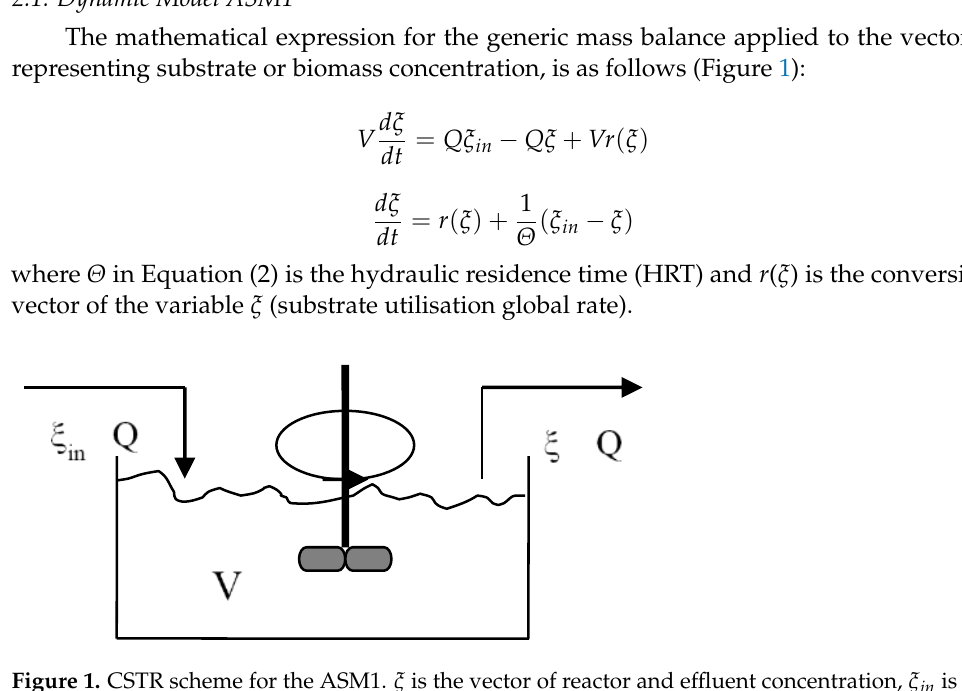
Figure 1. CSTR scheme for the ASM1. ξ is the vector of reactor and effluent concentration, ξ in is the vector of influent concentration, Q is the influent flow rate, and V is the reactor volume.